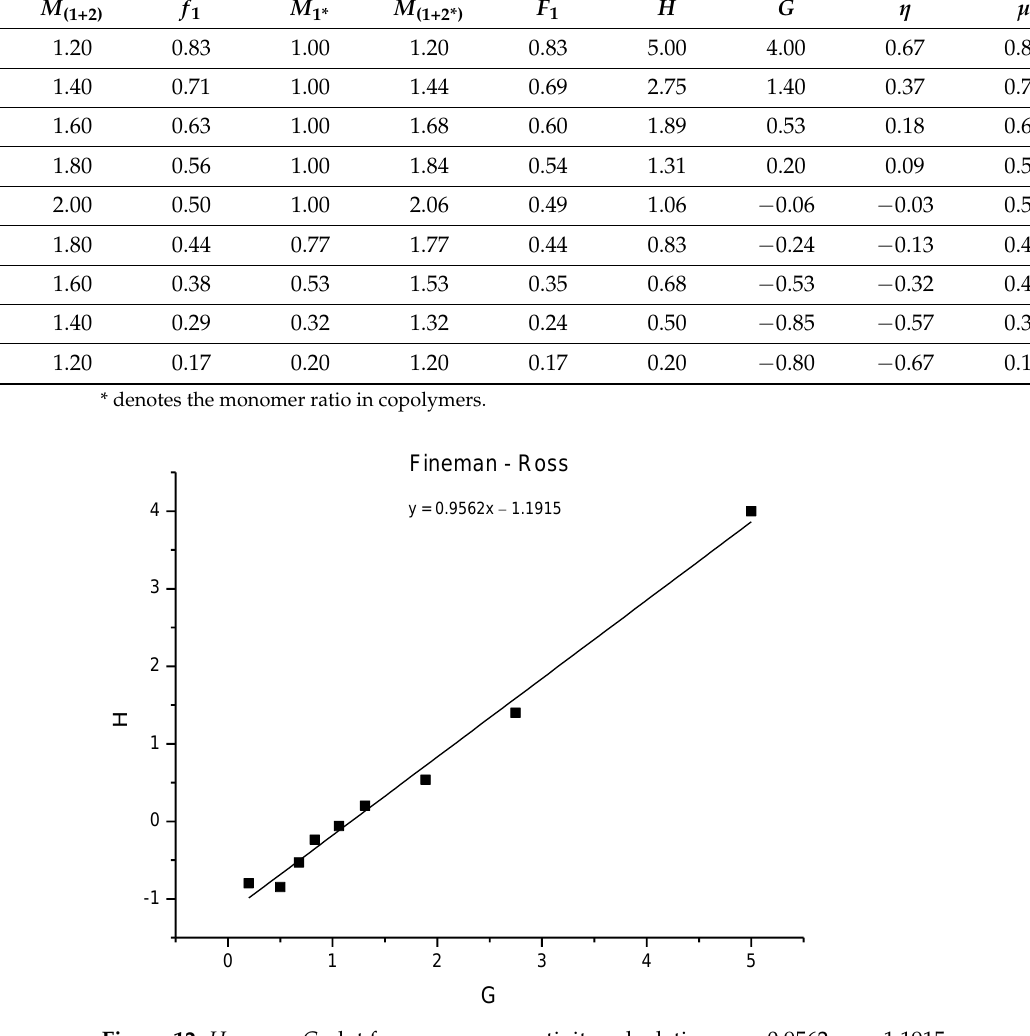
Figure 13. η versus µ plot for monomer reactivity calculation; r 1 = 0.9492, r 2 = 1.1115. After linear regression, the straight line provided r 1 when µ = 1 and r 2 when µ = 0. The values obtained by this method were similar to those obtained by the Fineman – Ross